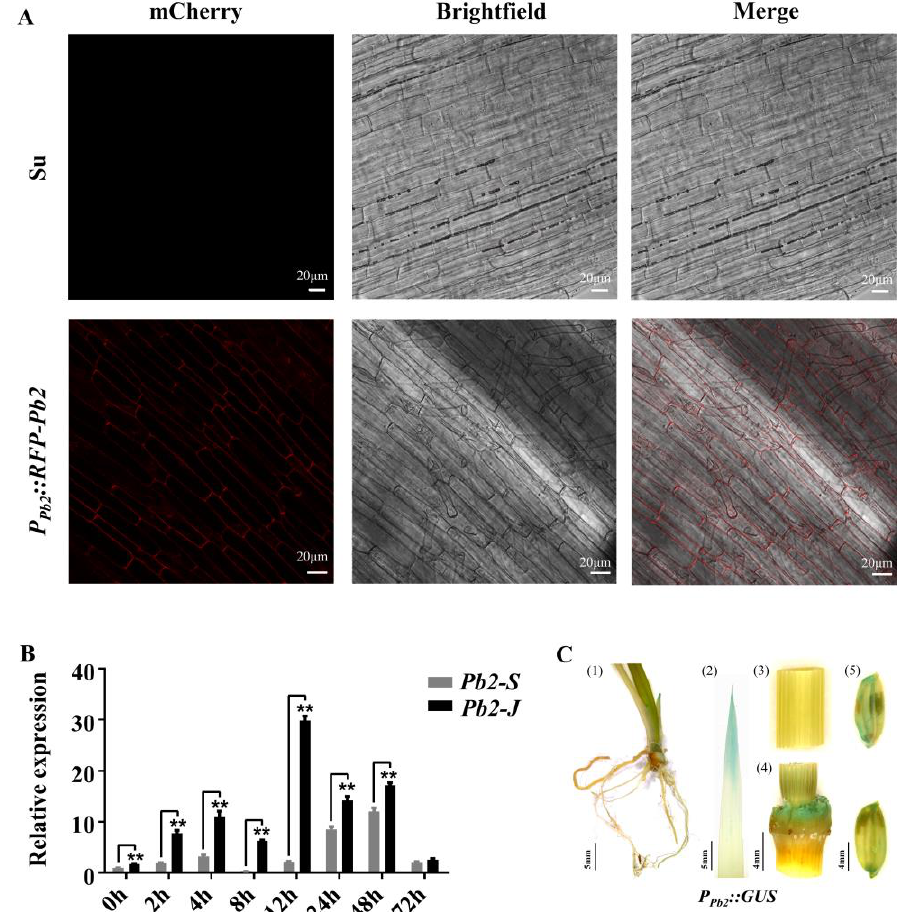
Figure 5. Specific expression of Pb2 . ( A ) Microscopic observation of P Pb2 :: RFP-Pb2 root tip subcellular localization. Pb2 is located to the plasma membrane. The transgenic receptor plant Suyunuo (Su) was used as the control. ( B ) The expression pattern of the Pb2 gene in landrace Jiangnanwan and Suyunuo inoculated with M. oryzae Hoku1 was investigated by qPCR. Jiangnanwan and Suyunuo young panicles were collected 0, 2, 4, 8, 12, 24, 48 and 72 h after inoculation. Amplification of OsAc- tin1 (LOC_Os03g50885) was used as an internal control. The expression level on the ordinate is the relative expression level after excluding the rhythmic interference of sterile water inoculation. Error bars represent standard deviation of three technical replicates; (** p < 0.01). ( C ) GUS staining to de- tect tissue-specific expression. (1) and (2) Staining of roots, leaf sheaths and leaves of three-week- old seedlings of P Pb2 ::GUS transgenic material. (3), (4) and (5): Staining of stems, stem nodes and grains of P Pb2 ::GUS transgenic materials at heading stage. 2.6. Pb2 Associated with Panicle and Leaf Blast Resistance In order to verify the function of Pb2 in rice blast resistance, complementation, over- expression and knockout, transgenic lines of Pb2-J , which was cloned from resistant culti- var Jiangnanwan, were constructed. When Pb2-J was complementary to the susceptible material Suyunuo, Pb2-J could effectively reduce the percentage of diseased grains and improve panicle blast resistance. However, the panicle blast resistance of Pb2-J was rela- tively moderate resistance (Figure 6E–G and Supplementary Figure S3A,B). The overex- pression in transgenic plants of Pb2-J in Suyunuo also showed enhanced panicle blast re- sistance (Figure 6E–G and Supplementary Figure S3C,D). Compared with the resistant cultivar Jiangnanwan, the knocked out transgenic plants of Pb2-J in Jiangnanwan showed more susceptibility in 2020 Nanjing, while only part of the line had a difference detected in other trials (Figure 6A–D and Supplementary Figure S4A–D). The complementary and overexpression of Pb2-J transgenic plants also showed obviously enhanced resistance to